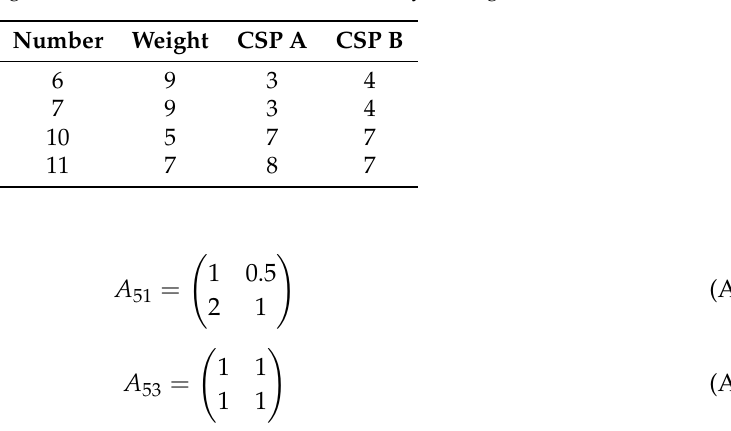
Table A2. Scorings of CSPs for Questions Relevant for Key